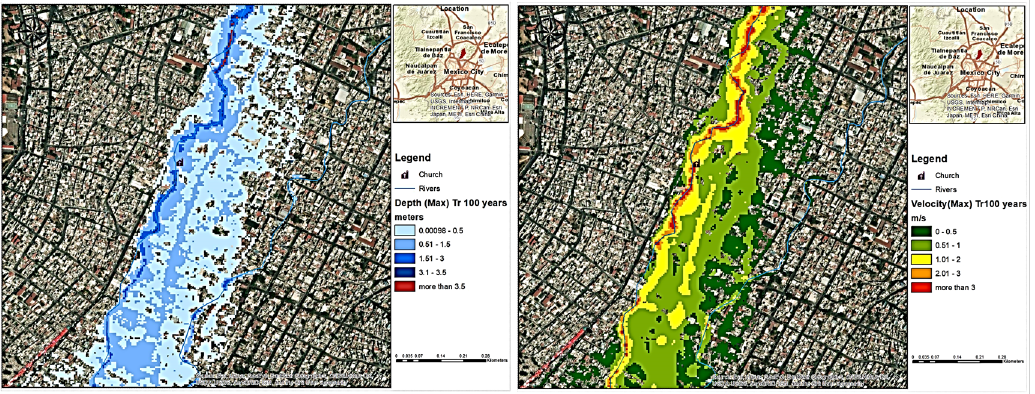
Figure 15. Floodplain expansion for flash flood with Tr = 100